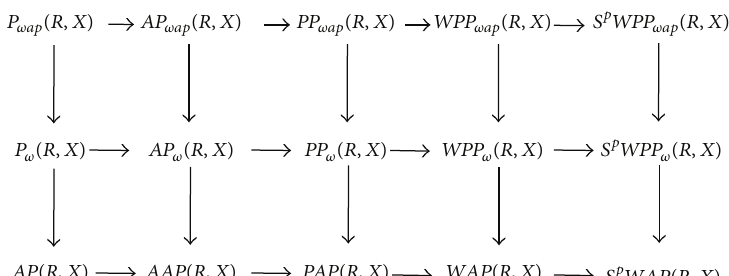
Figure 1: Relationship between anti-periodic, periodic or almost periodic functions and their extensions, where “ → ” denotes subset relation “ ⊂